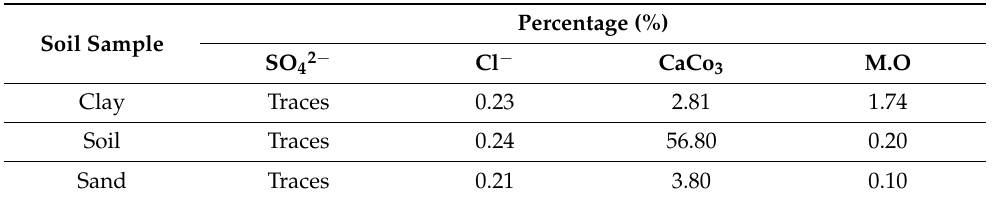
Table 1. Chemical composition of soil extracts and percentage. Soil